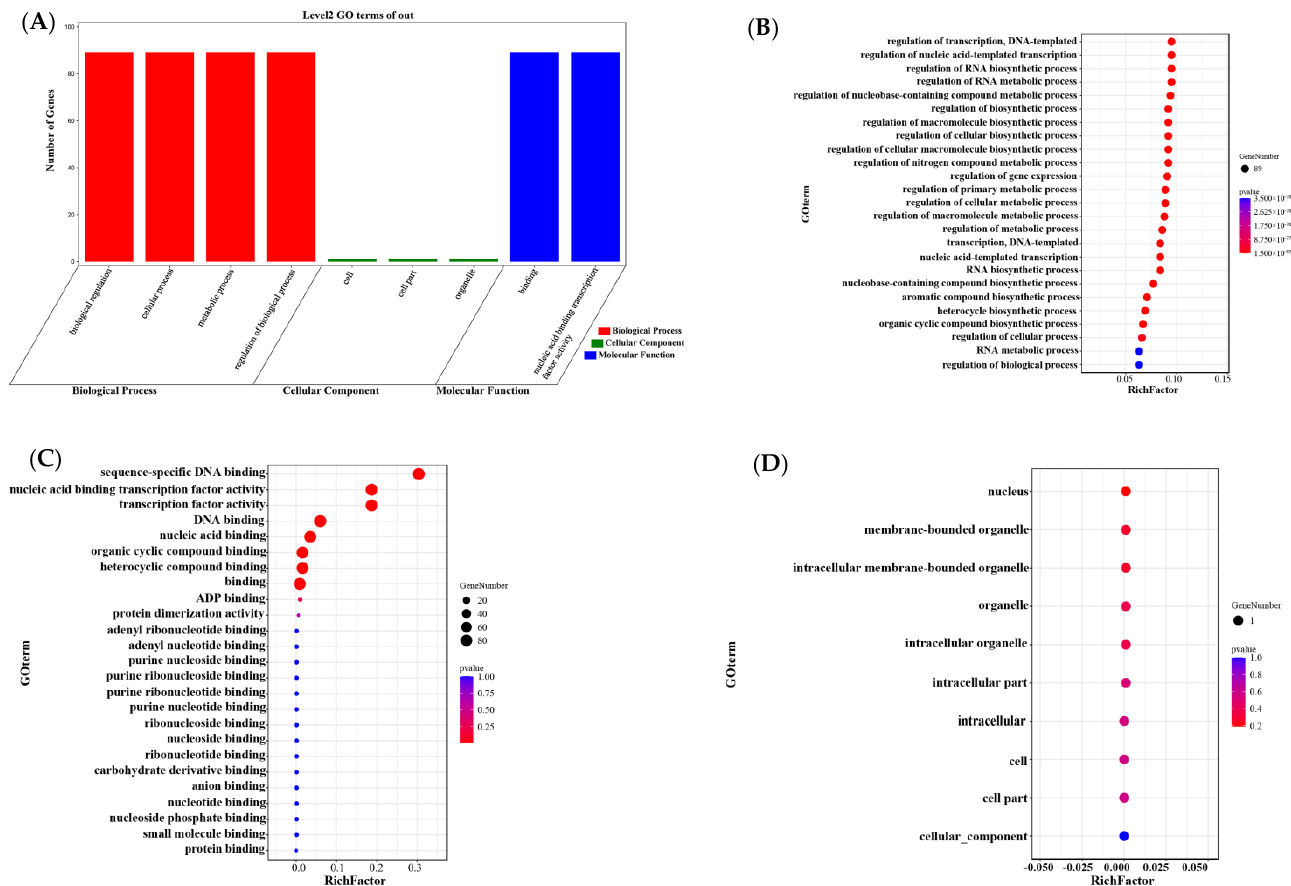
Figure 7. Gene Ontology (GO) annotation. ( A ) Direct count GO. Red bars represent biological processes (BP), blue bars represent molecular functions (MF) and green bars represent cellular compartments (CC); ( B ) Major Biological Process (BP); ( C ) Major Molecular Function (MF); ( D ) Cell Compartment (CC).